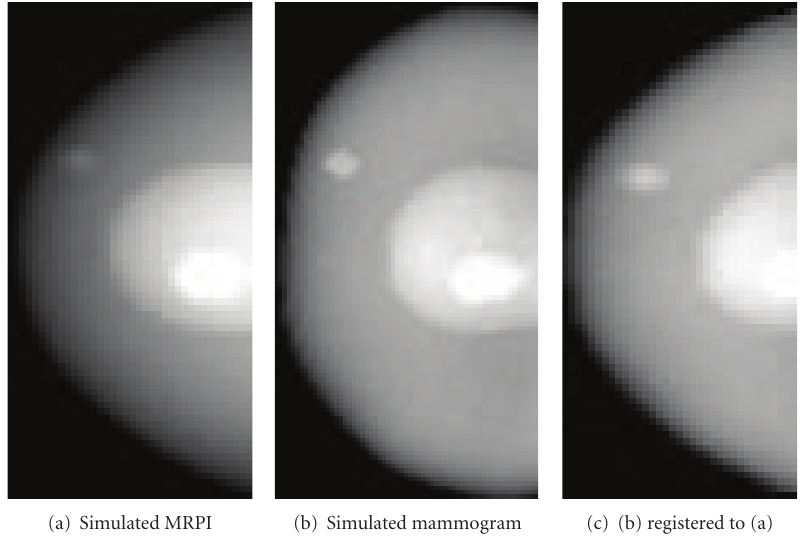
Figure 7: Mean intensity projections through deformed phantom before and after